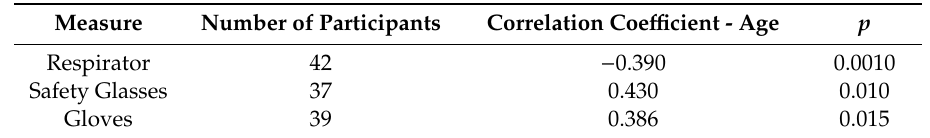
Table 3. Spearman’s rank-order correlation (r s ) between Age and use of Personal Protective equipment (PPE).